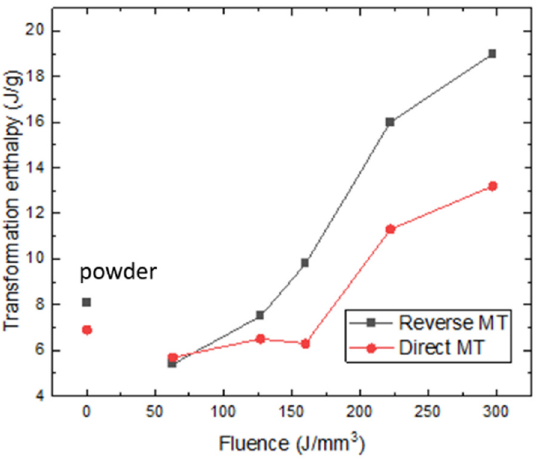
Figure 4. Evolution of the transformation enthalpies of the direct and reverse martensitic transfor- mation of the NiTi powder and the NiTi samples, produced at varying the laser fluence. EDXS measurements were performed on XZ sections of the as-built samples; nine area measurements of about 0.5 × 0.5 mm 2 were acquired for each specimen, spread over a total area of about 2.5 × 2 mm. Figure 5 shows the semiquantitative trend of Ni and Ti content, expressed in atomic percentage (at. %), at varying laser fluence. Figure 5. Compositional analysis, carried out with EDS, of the NiTi built samples processed at dif- ferent laser fluence values. No significant O content was observed, without any variation among the position in the specimens; consequently, it was disregarded from calculations. In the graph, two re- gions can be clearly observed; at low laser fluence values up to 63–160 J/mm 3 , the compo- sitions of the specimens are quite constant and in good agreement with the nominal com- position of the starting powder, i.e., Ni content of about 51.0 ± 0.3 at. %, quite close to the nominal 50.8%at. By increasing further the laser fluence, up to 297 J/mm 3 , Ni content de- creased down to 50.4 ± 0.2 at. %, with a consequent increase in Ti content, was detected